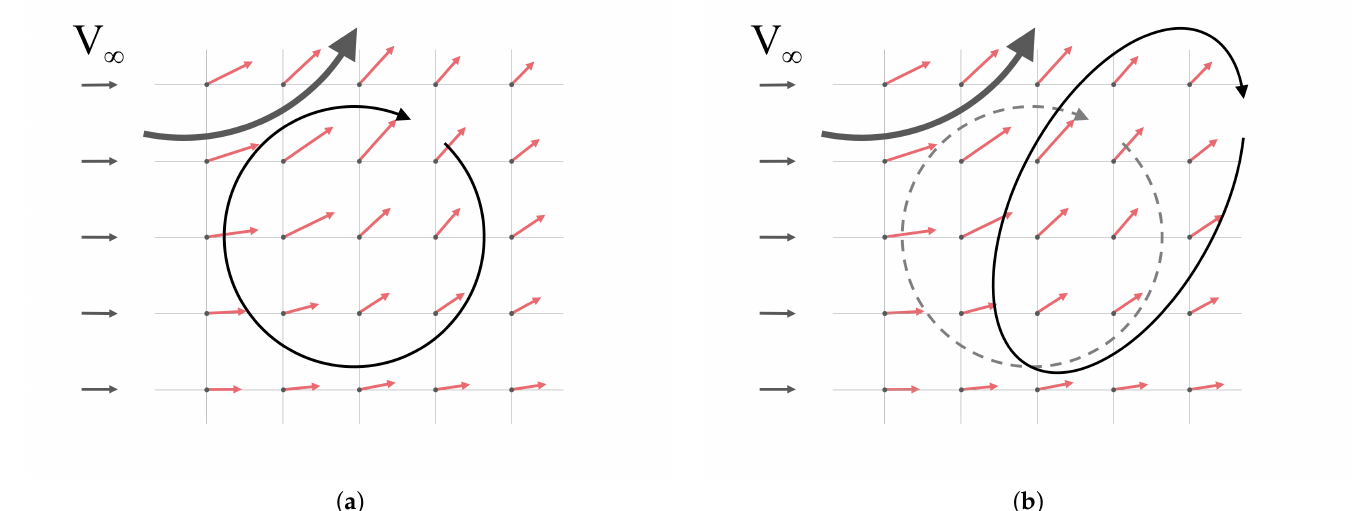
Figure 6. Point-wise velocity for small eddy in a uniform flow with influence from a large neighboring eddy: ( a ) Initial Eddy Position. ( b ) Convected Eddy